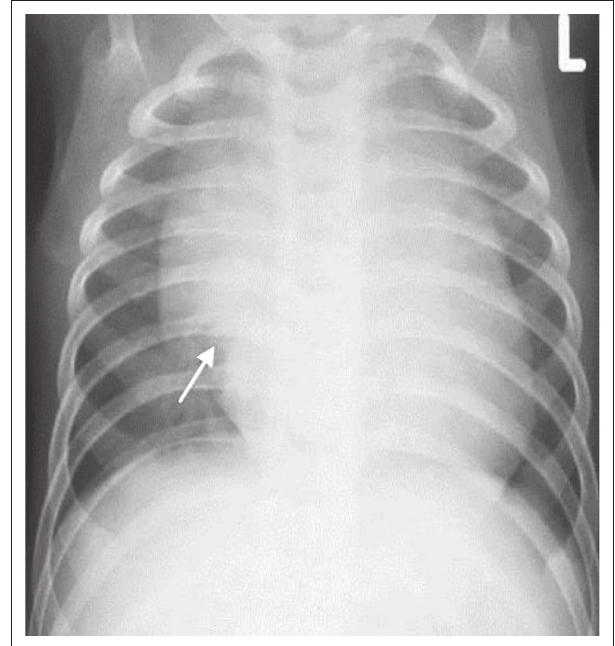
FIGURE 3: Frontal chest radiograph. The left lobe of the thymus (arrow) projects over the left hilum. The left pulmonary artery is clearly visible through the thymic shadow.